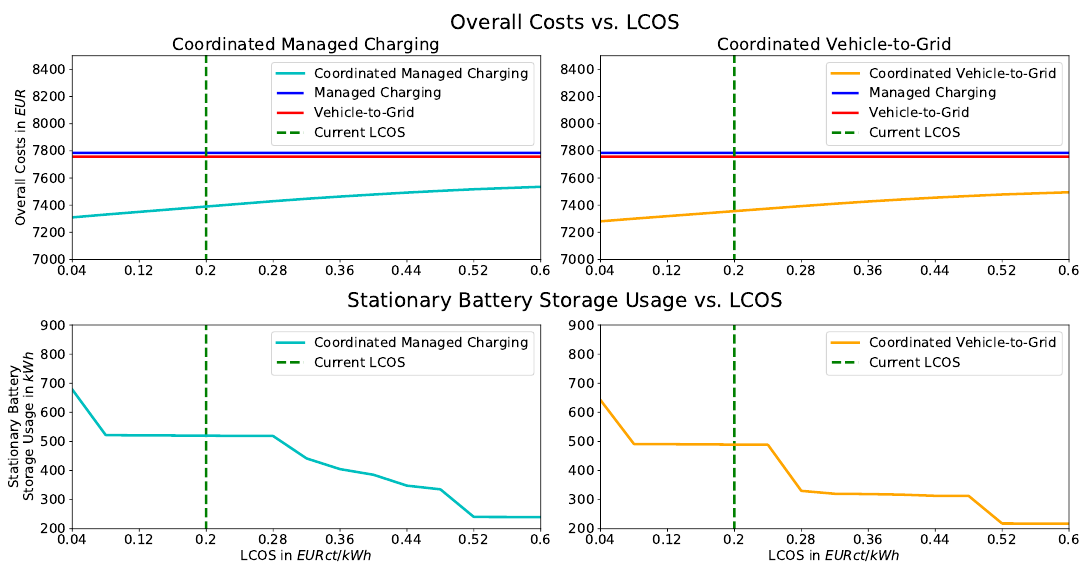
Figure 6. Levelized costs of storage vs. overall costs and stationary battery storage